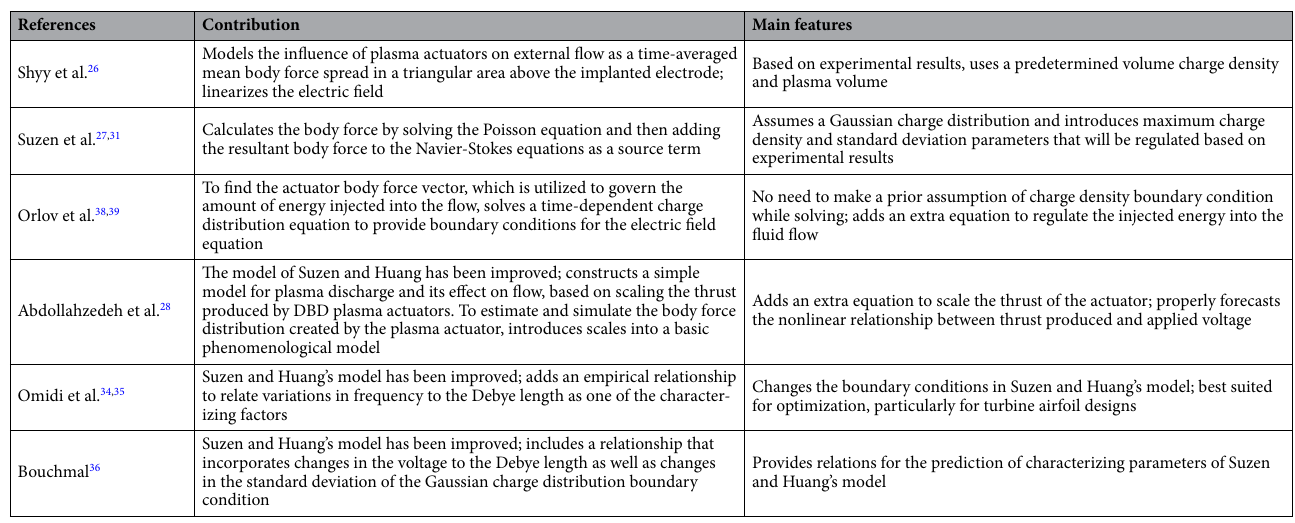
Table 1. Summary of the features and contributions of the phenomenological models that are similar to the one